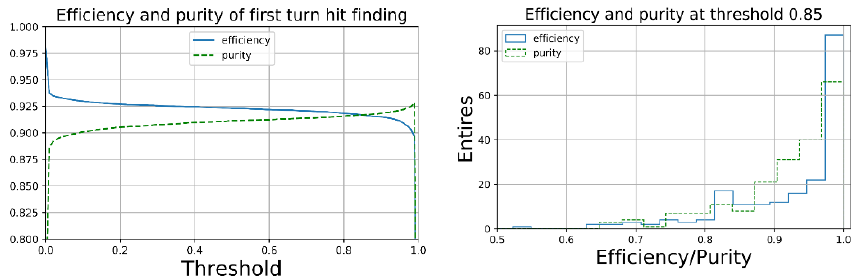
Fig.7. Left is the ROC curve of the efficiency and purity. Right is the efficiency and purity on threshold at